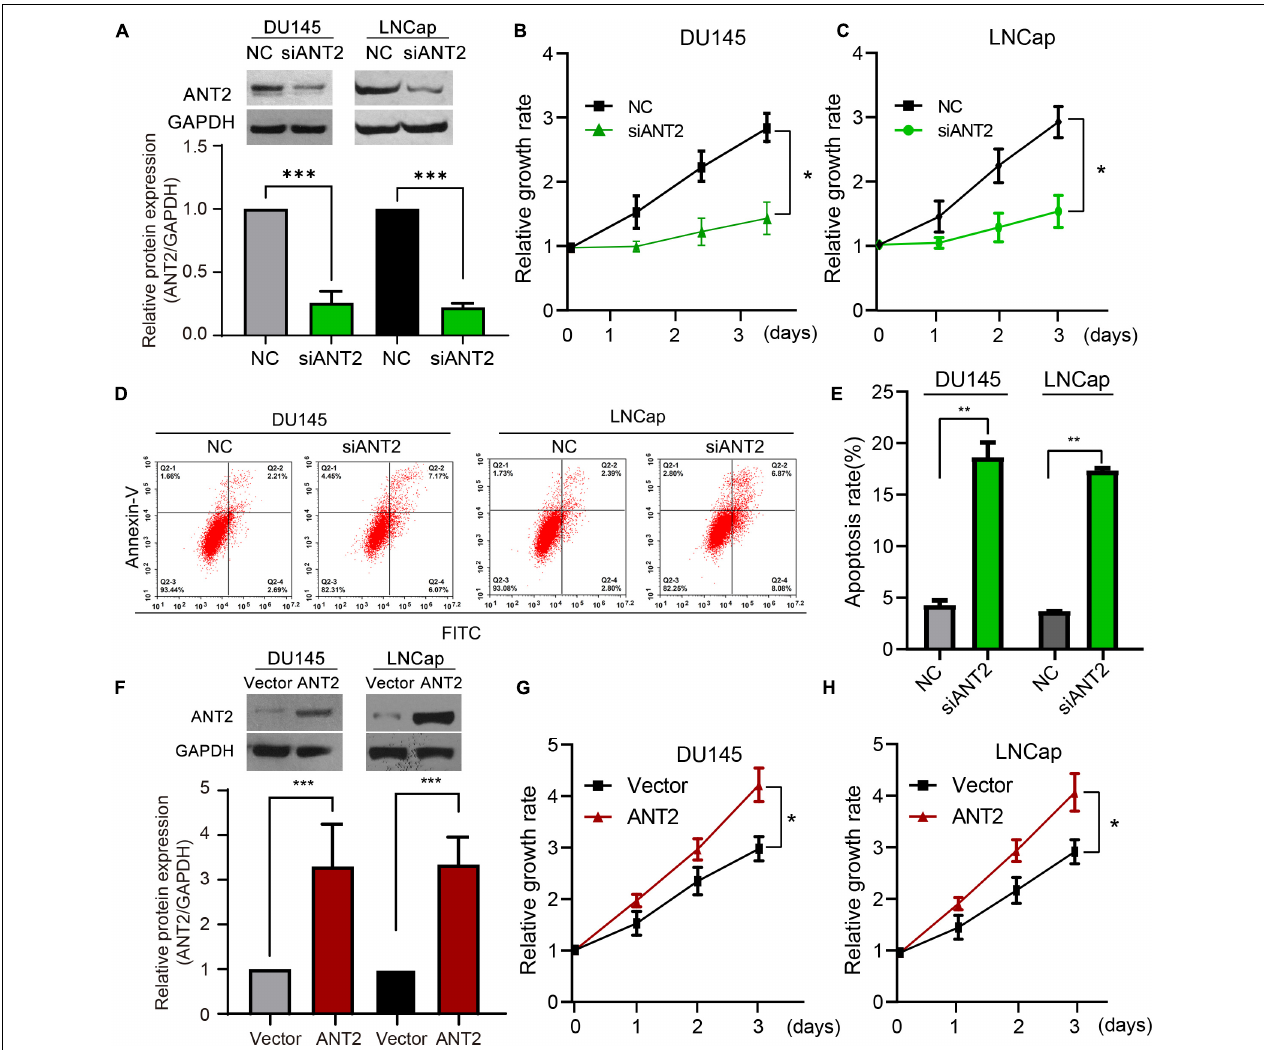
FIGURE 2 | Effects of ANT2 overexpression and silencing on prostate cancer cell proliferation and apoptosis. (A) A siRNA was designed to target the mRNA sequence of human ANT2. The effectiveness and specificity of the siRNA (siANT2) fragment was verified by western blot assay in DU145 and LNCaP cells. (B,C) After ANT2 gene silencing, proliferation of DU145 and LNCaP cells decreased. (D) Detection of apoptosis by Annexin V–PI double-label flow cytometry: ANT2 gene silencing inhibited prostate cancer cell growth and induced apoptosis. (E) Apoptosis in LNCaP and DU145 cells was significantly increased after ANT2 gene silencing. (F) RNA was extracted from prostate cancer cells and reverse transcribed. ANT2 cDNA was amplified by PCR, cloned into the indicated vector, and sequenced. Protein expression was monitored to confirm overexpression of ANT2, and the validity and specificity of the construct were verified by western blot assay. (G) Overexpression of ANT2 promoted proliferation of DU145 and LNCaP cells. (H) Detection of apoptosis by Annexin V–PI double-label flow cytometry: overexpression of ANT2 had no significant effect on the growth or apoptosis of prostate cancer cells. * p < 0.05; ** p < 0.01; *** p < 0.001; ns, no significant